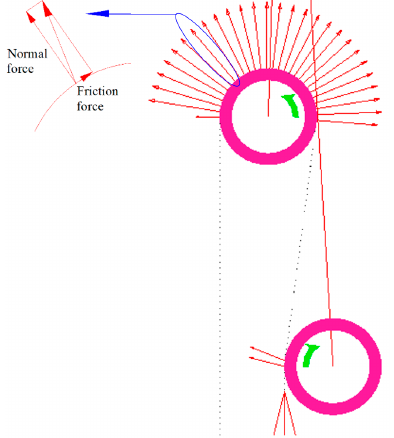
Figure 13. Distribution of the contact force line between the rope and pulleys.